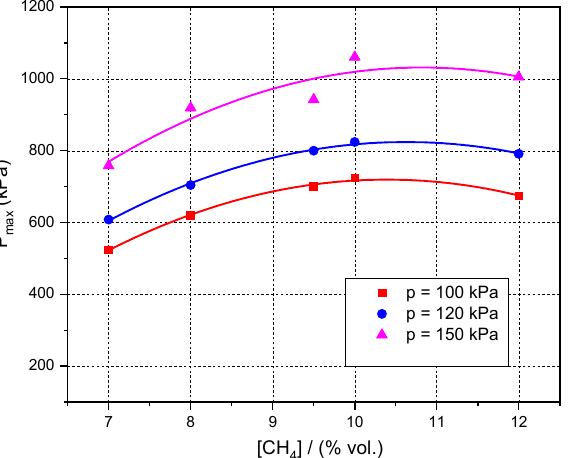
Figure 8. Experimental maximum explosion pressures at different initial pressures and composition. A comparison of peak explosion pressures obtained in normal conditions and in the presence of radioactive sources can be seen in Figure 9, where little data from literature were also plotted. A more comprehensive comparison of our results with reference data from literature can be found in Table